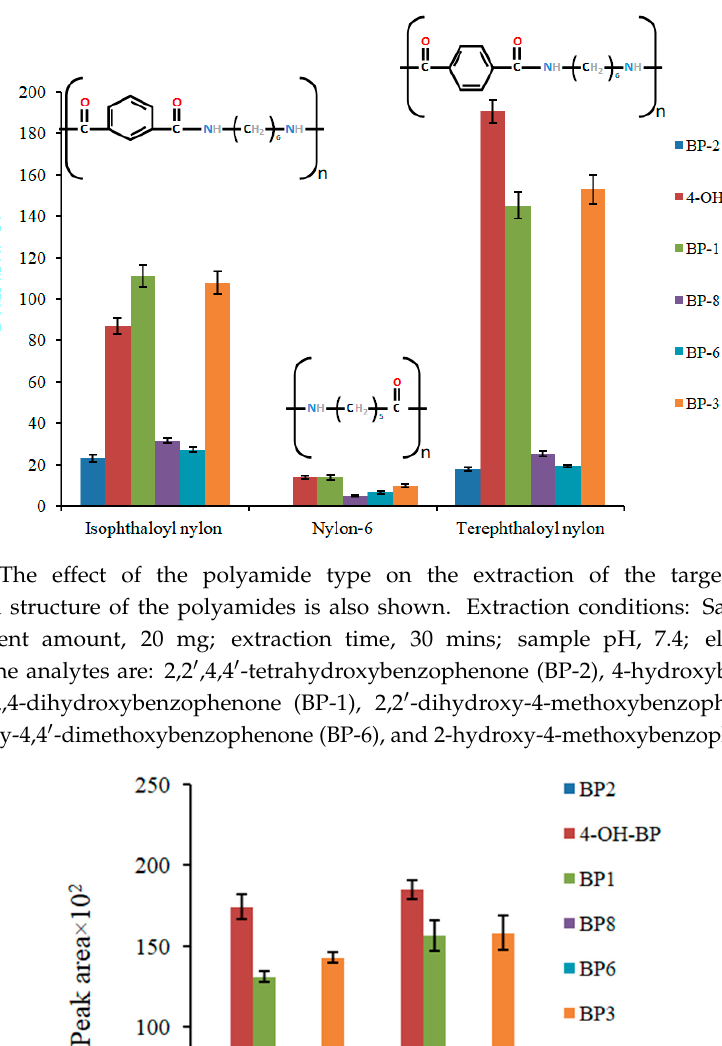
Table 1. A list of the variables studied in extraction optimization.